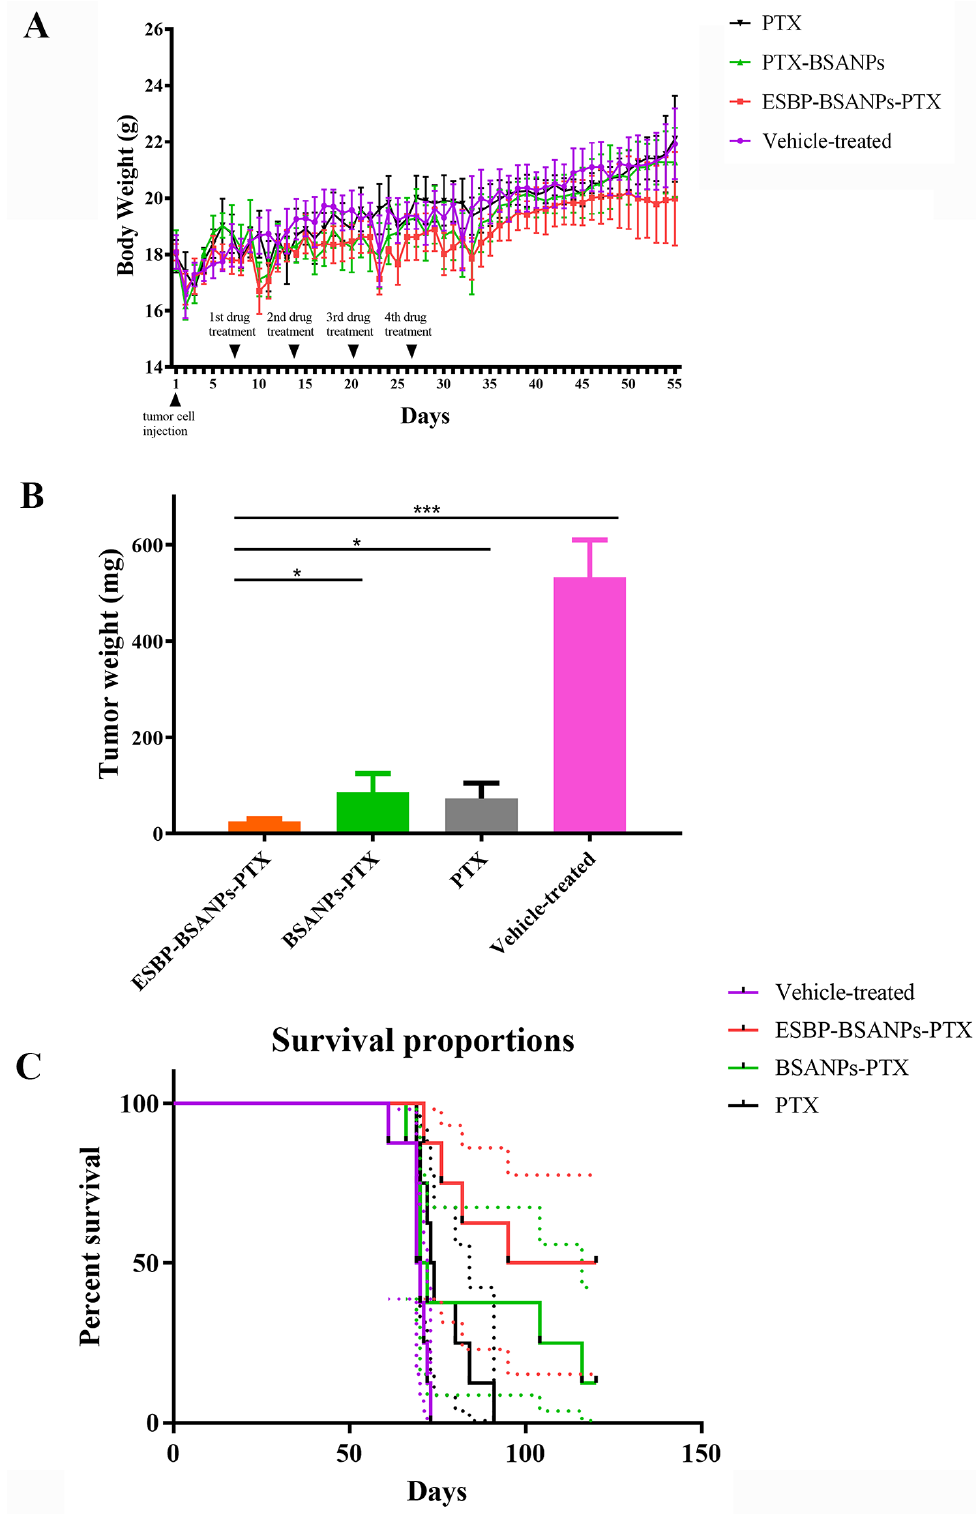
Figure 7. After four cycles of treatment: ( A ) body-weight time curve in each group of mice for 55 days (mean ± SD, n = 8). ( B ) Tumor weight in each group of mice after finishing four cycles of treatment was calculated (mean ± SD, n = 5). ( C ) 120-day survival curves of mice in different treatment groups (ESBP-BSANPs-PTX-, BSANPs-PTX-, PTX-treated and vehicle-treated control group) ( n = 8). * p < 0.05 and *** p <